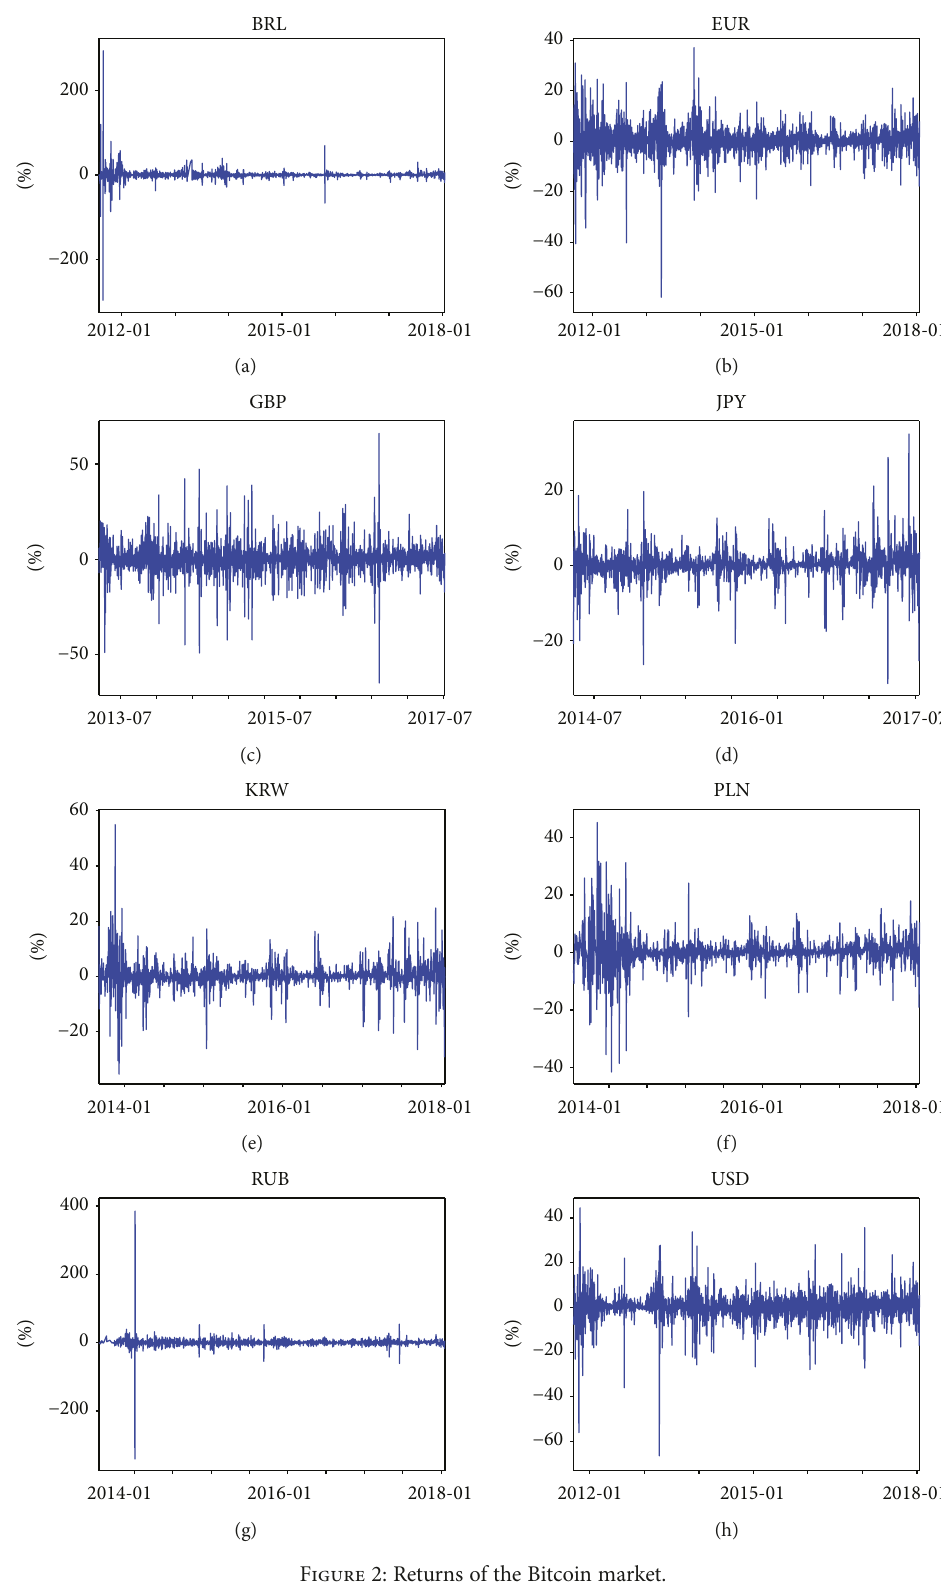
Figure 2: Returns of the Bitcoin